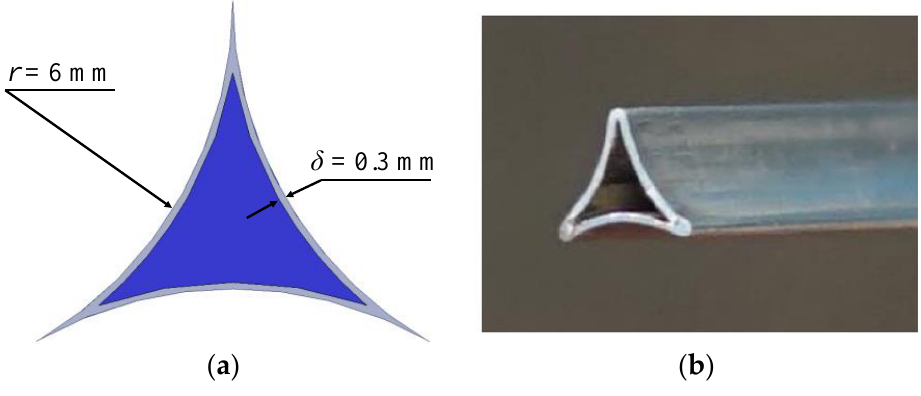
Figure 5. Scheme ( a ) and photo ( b ) of the channel’s cross-section.